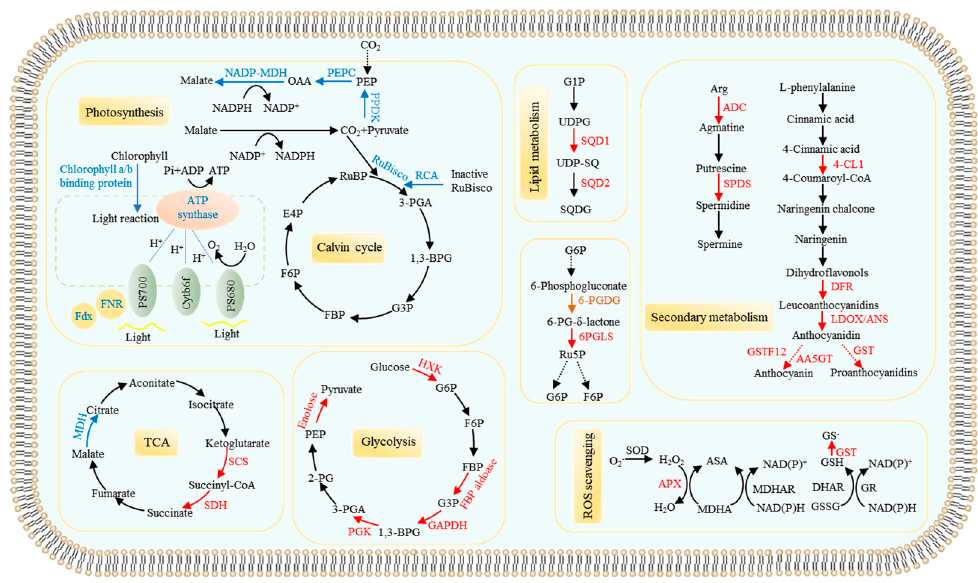
Figure 1. A model of integration of different adaptive strategies to P deficiency regulated by DAPs in shoots or leaves. The DAPs identified by proteomic analysis associated with different metabolic pathways. Red color indicates proteins with increased accumulations in plants under low-P conditions; blue color indicates proteins with decreased accumulations in plants under low-P conditions; brown color suggests proteins exhibiting either up-regulated or down-regulated accumulations under low-P conditions; dashed lines indicate multiple steps; AA5GT, anthocyanidin 5-O-glucosyltransferase; ACC, 1-aminocyclopropane-1-carboxylate; ADP, adenosine diphosphate; ANS, anthocyanidin synthase; APX, ascorbate peroxidase; Arg, arginine; ADC, arginine decarboxylase; ASA, ascorbic acid; ATP, adenosine triphosphate; 1,3-BPG, 1,3-bisphosphoglycerate; 4-CL1, 4-coumaroyl-CoA ligase 1; DFR, dihydroflavonol-4-reductase; DHAR, dehydroascorbate reductase; E4P, erythritos-4- phosphate; F6P, fructose-6-phosphate; FBP aldoase, fructose-1,6-bisphosphate aldolase; FBP, fructose- 1,6-bisphosphate; FNR, ferredoxin-nitrite reductase; Fdx, ferredoxin; G1P, glucose-1-phosphate; G3P, glyceraldehyde-3-phosphate; G6P, glucose-6-phosphate; 6-PGDG, 6-phosphogluconate de- hydrogenase; GAPDH, glyceraldehyde-3-phosphate dehydrogenase; GR, glutathione reductase; GSH, reduced glutathione; GSSG, oxidized glutathione; GST, glutathione-S-transferase; GSTF12, glutathione-S-transferase F12; HXK, hexokinase; LDOX, leucoanthocyanidin dioxygenase; MDH, malate dehydrogenase; MDHA, monodehydroascorbate; MDHAR, monodehydroascorbate reductase; Met, methionine; NADP-MDH, NADP-malate dehydrogenase; OAA, oxaloacetic acid; PEP, phos- phoenolpyruvate; PEPC, phosphoenolpyruvate carboxylase; 2-PG, 2-phosphoglycerate; 3-PGA, 3- phosphoglycerate; 6-PG- δ -lactone, 6-phosphoglucono- δ -lactone; 6PGLS, 6-phosphogluconolactonase; PGK, phosphoglycerate kinase; Pi, phosphate; PPDK, pyruvate orthophosphate dikinase; RCA, ribu- lose bisphosphate carboxylase/oxygenase activase; Ru5P, Ribulose-5-phosphate; RuBP, Ribulose-1,5- diphosphate; SAM, s-adenosyl methionine; SCS, succinyl-CoA synthetase; SDH, succinate dehydroge- nase; SOD, superoxide dismutase; SPDS, spermidine synthase; SQD1, UDP-sulfoquinovose synthase; SQD2, sulfoquinovosyl diacylglycerol synthase; SQDG, sulfoquinovosyl diacylglycerol; TCA cycle, tricarboxylic acid cycle; UDPG, uridine diphosphoglucose; UDP-SQ,